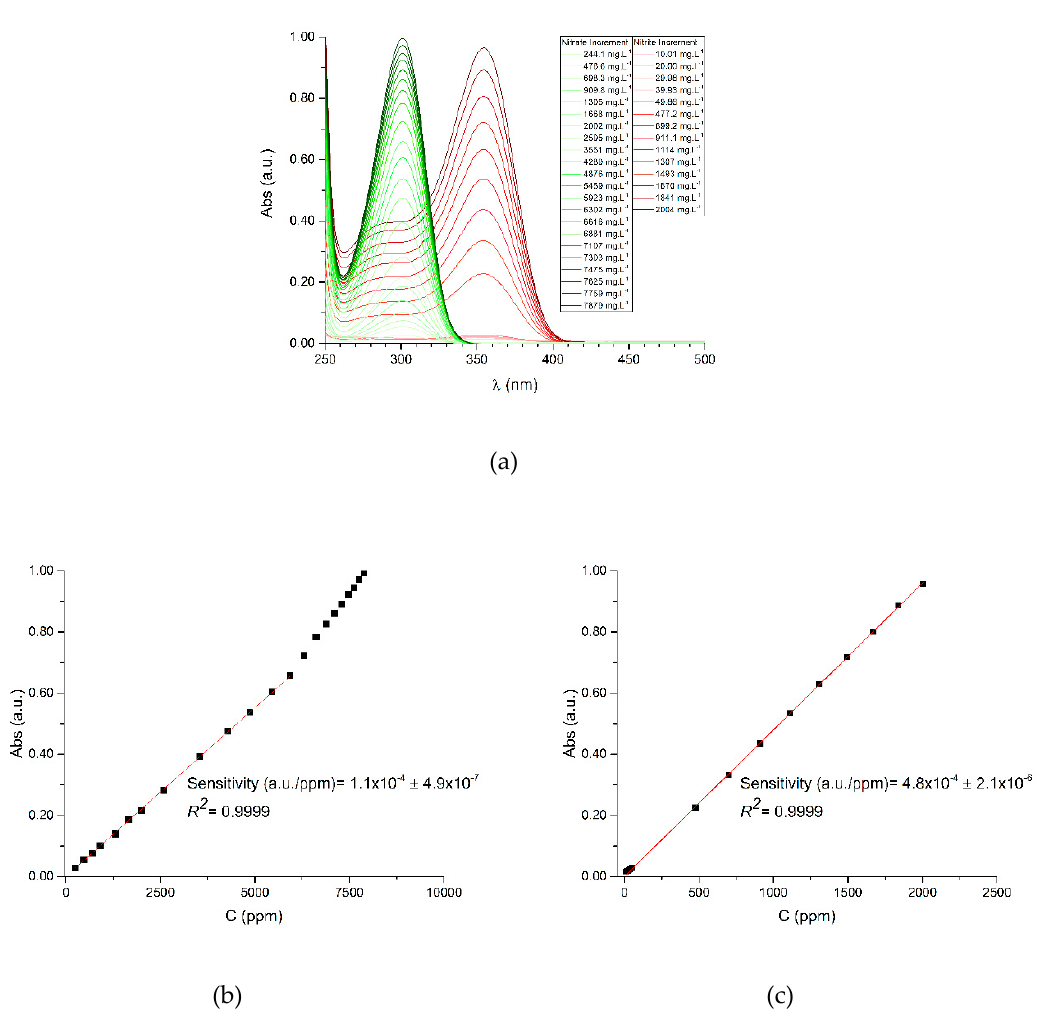
Figure 3. DUVA calibration results. ( a ) Calibration chromatogram for nitrate and nitrite, on green and red plotting, respectively; calibration curves for ( b ) nitrate and ( c ) nitrite.